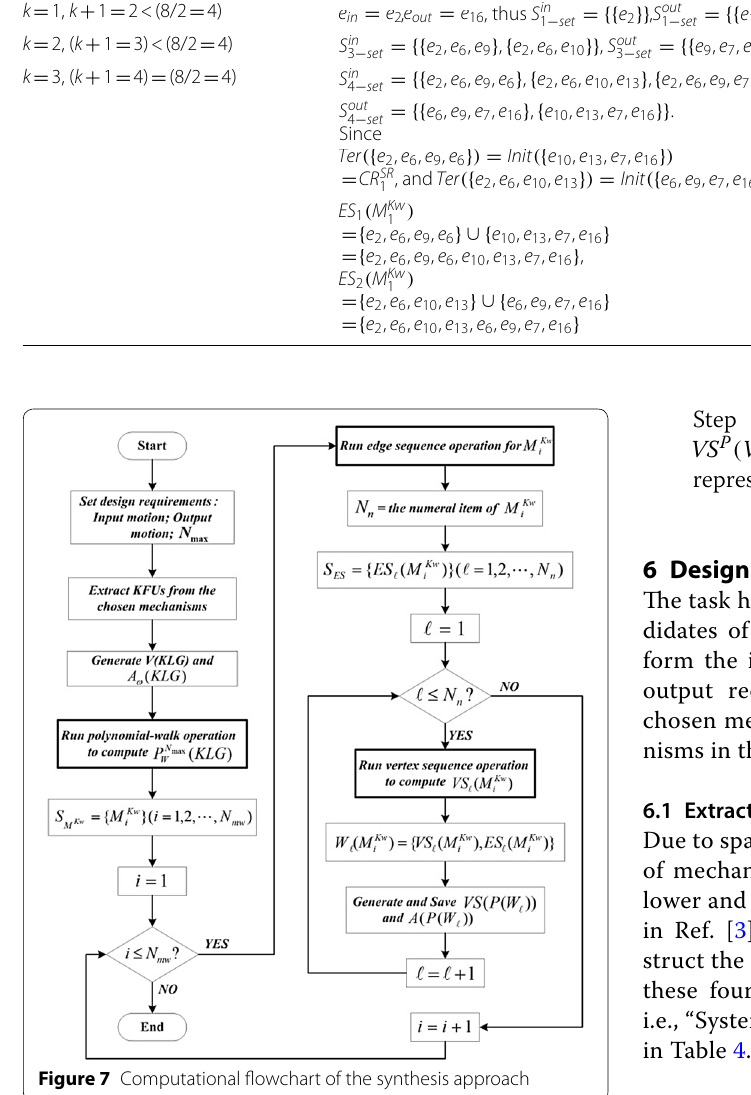
Table 3 Execution steps and execution results for each step of edge sequence algorithm with M Kw 1 acting as an example Execution steps Results for each step